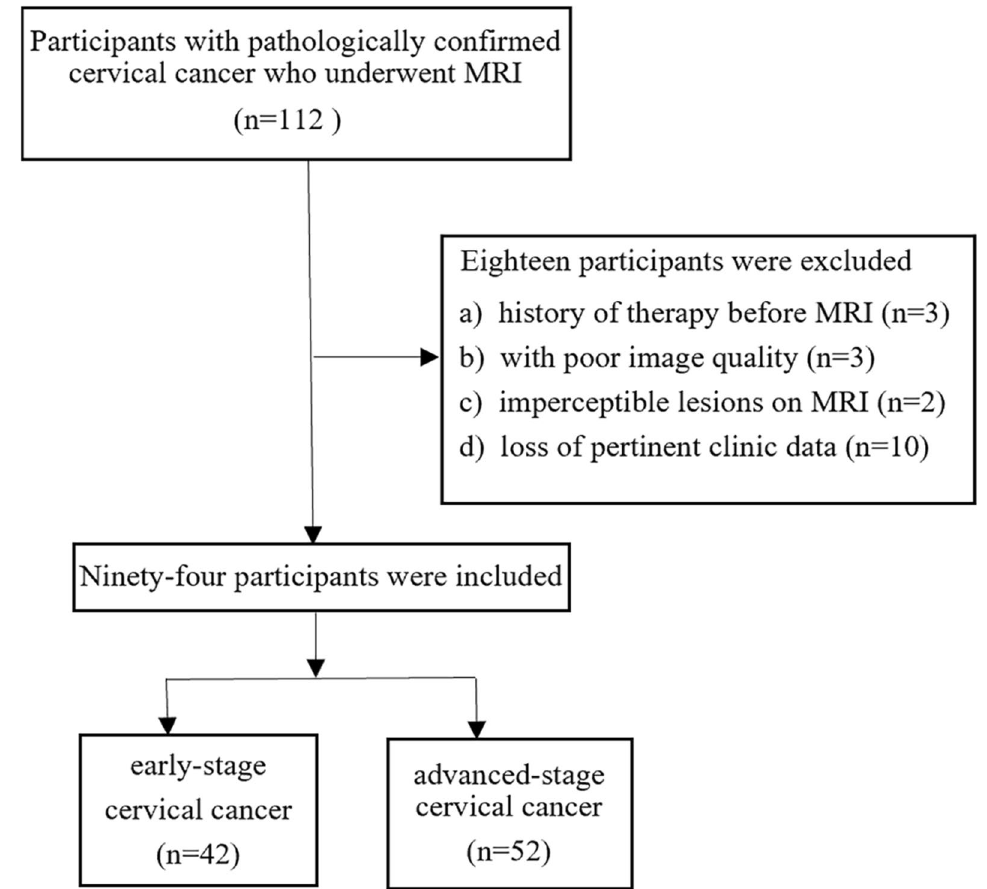
Fig. 1 The flowchart of patient selection